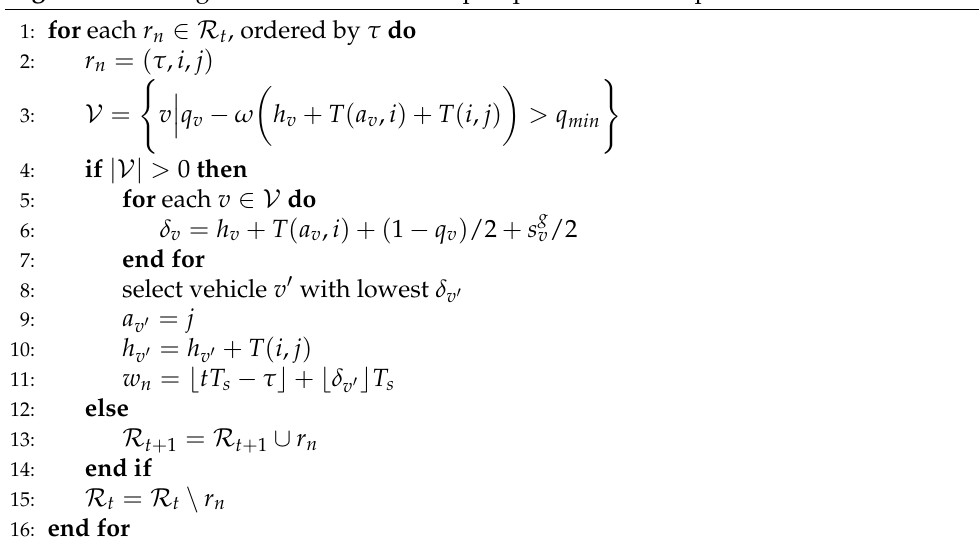
Algorithm 2 Assignment of vehicles to trip requests at time step t